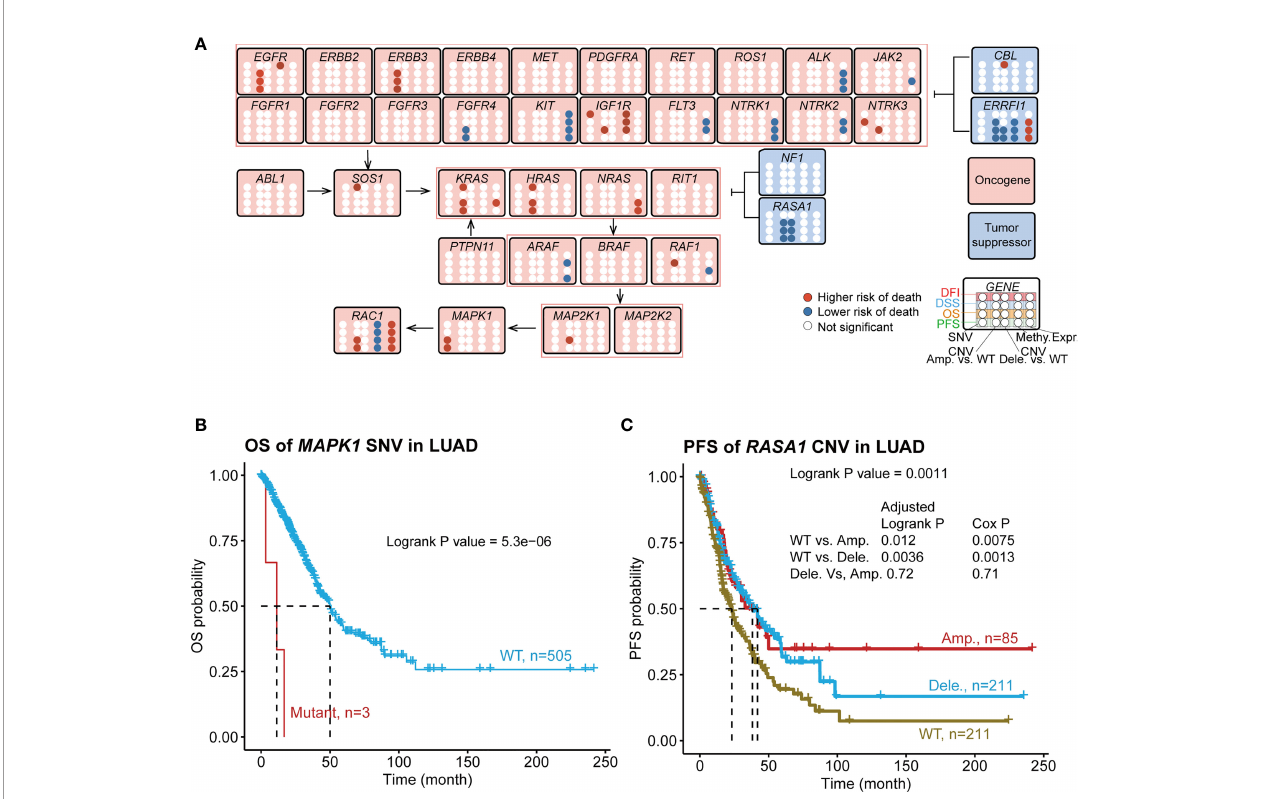
FIGURE 4 | Associations of RTK/RAS pathway mutation with four survival types of LUAD. (A) Summary of the survival results of OS, PFS, DSS, and DFI of the SNV, CNV, methylation, and mRNA expression of RTK/RAS pathway genes. Blue and red points represent the low and higherhigh risks of death for SNV/CNV/high methylation/high expression groups, respectively. For CNV, Amp. vs. WT and Dele. vs. WT were compared, respectively. (B) K – M survival curves showing the OS difference between MAPK1 SNV groups. (C) PFS difference between RASA1 CNV groups. Pair wise comparison was performed, and P value was adjusted by